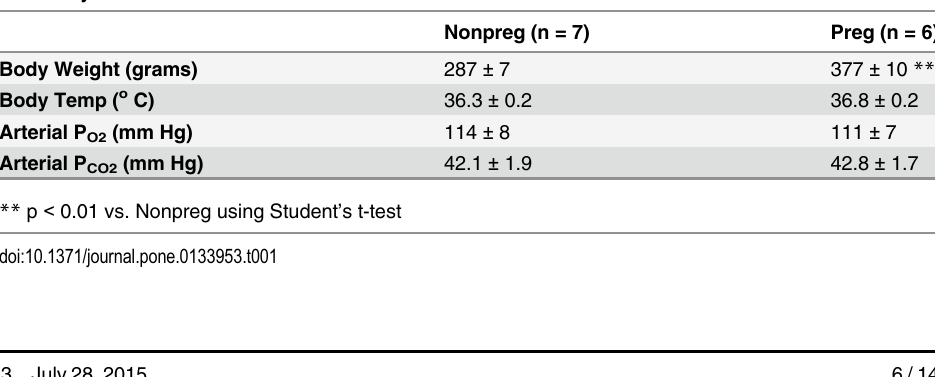
Table 1. Physiological parameters of nonpregnant (Nonpreg) and late-pregnant (Preg) rats under chloral hydrate anesthesia for seizure threshold